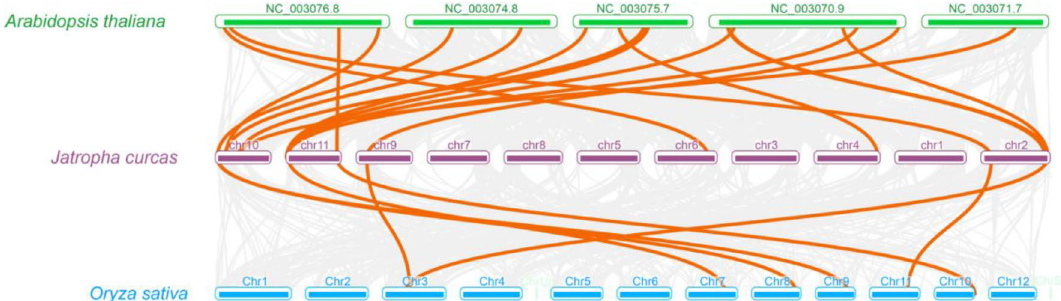
Figure 5. Synteny analyses of the JMJ genes among the three species J. curcas , Oryza sativa and Arabidopsis thaliana . The collinear blocks within J. curcas and other specie genomes were displayed by the gray lines. The syntenic JMJ gene pairs between J. curcas and other species were highlighted with the red